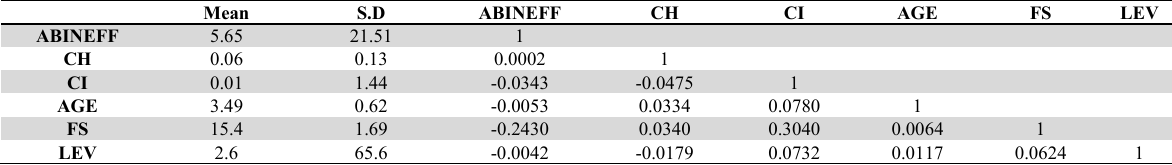
Descriptive Statistics and Correlation Analysis (Pakistan Scenario)